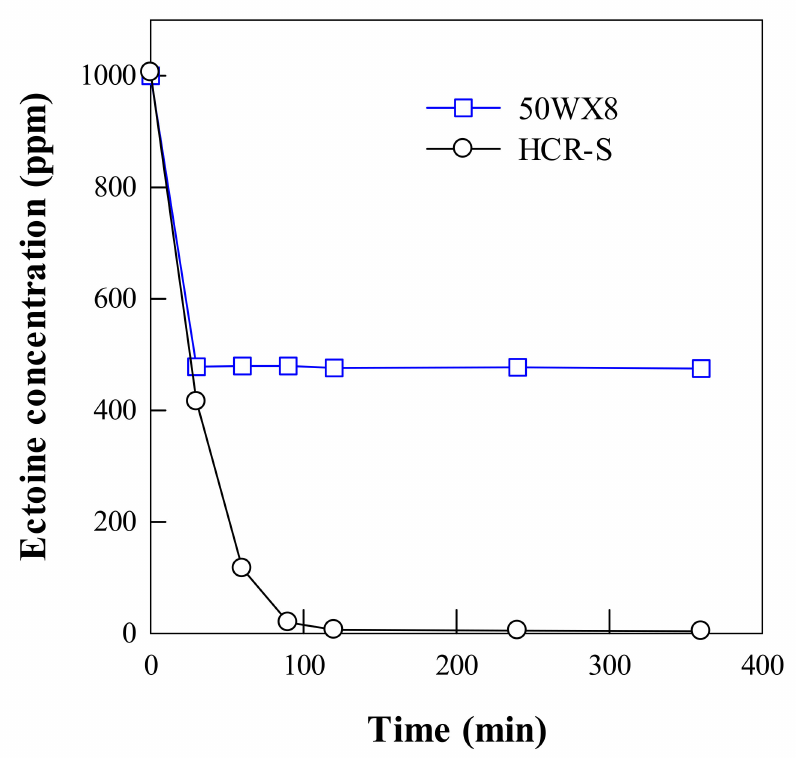
Figure 1. Effect of adsorption time on ectoine adsorption using ion-exchange resin (ectoine = 1000 mg/L, solution/resin = 10 mL/g, reaction time = 6 h, stirring rate = 100 rpm, temper- ature = 35 ◦ C).